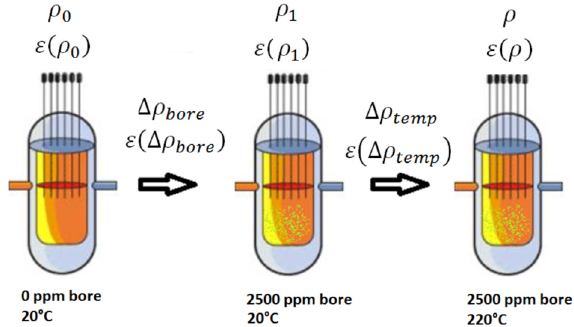
Fig. 1. Steps of uncertainties accumulations.